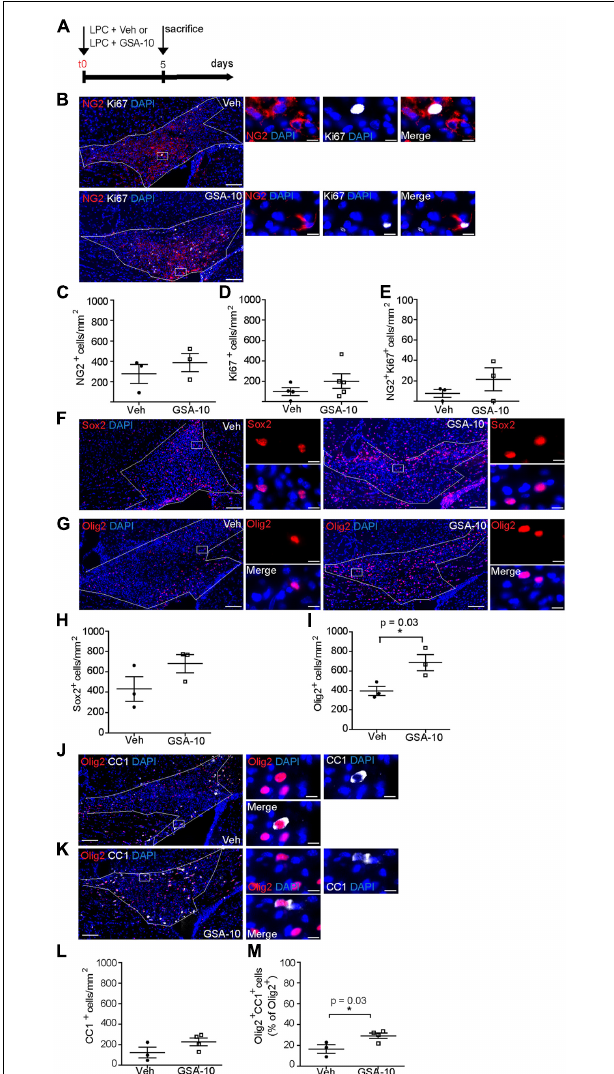
FIGURE 6 | GSA-10 increases Olig2 + cells during remyelination of the corpus callosum. (A) Scheme of LPC-induced focal demyelination and GSA-10 treatment. LPC was injected into the corpus callosum of adult mice in the presence of vehicle (Veh) or the quinolinone GSA-10. Mice were perfused 5 days post-lesion to allow OPC recruitment. (B) Distribution of Ki67 (white) proliferation marker together with the proteoglycan-NG2 marker (red) inside the lesioned corpus callosum of Veh and GSA-10 treated brains. (C–E) GSA-10 does not modify the density of (C) NG2 + , (D) Ki67 + , and (E) NG2 + Ki67 + cells inside the lesion. Mean ± SEM, n = 3–4 experimental replicates. (F,G) Distribution of the oligodendroglial markers (F) Sox2 and (G) Olig2 (red) inside the lesioned corpus callosum of Veh or GSA-10 treated brains. (H,I) GSA-10 increases the density of Olig2 + cells (I) ( p = 0.01) and does not significantly modify the density of Sox2 + (H) cells inside the lesion. (J,K) Distribution of CC1 (white) marker labeling-differentiated oligodendrocytes together with the Olig2 marker (red), inside the lesioned corpus callosum of Veh and GSA-10-treated brains. (L,M) GSA-10 increases the density of CC1 + Olig2 + cells and their percentage in the Olig2 population inside the lesion ( p = 0.03). Mean ± SEM, n = 3–5 experimental replicates. White squares are magnified on the right (B,F,G,J,K) of the main panels, showing positive cells in merge and single channel with the nuclear marker DAPI (blue). Scale bar: (B,F,G) = 100 µ m; all magnifications = 10 µ m. * p <